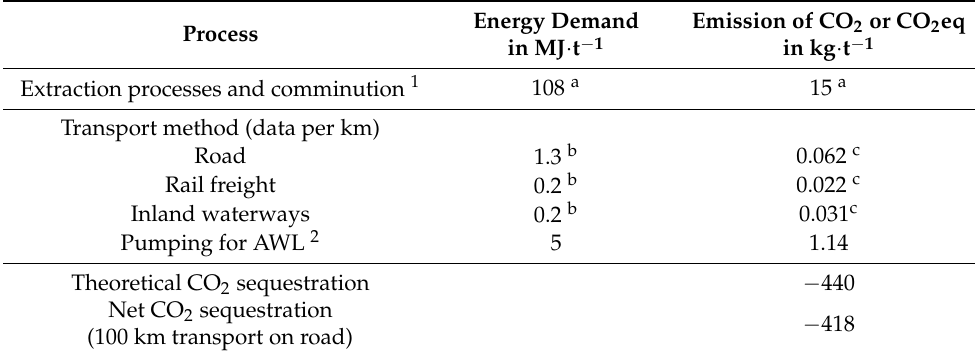
Table 1. Energy demand and CO 2 emissions of the major process steps during the application of AWL. Negative values represent CO 2 uptake. Energy Demand Emission of CO 2 or CO 2 eq Process in MJ · t − 1 in kg · t − 1 Extraction processes and comminution 1 108 a 15 a Transport method (data per km) Road 1.3